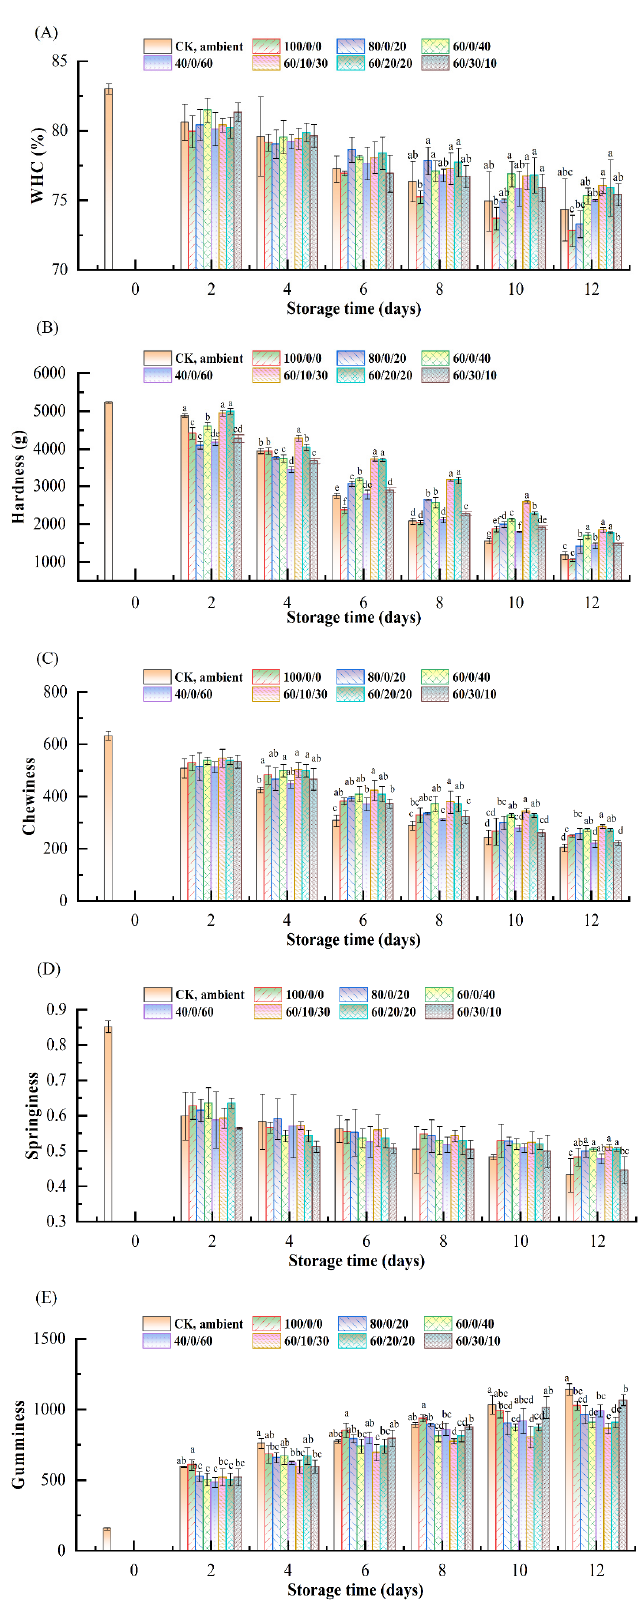
Figure 3. Changes of WHC ( A ), hardness ( B ), chewiness ( C ), springiness ( D ), and gumminess ( E ) of salmon fillets under MAP containing different CO 2 /O 2 /N 2 ratios at 4 °C. Different lowercase letters (a–d) represent significant differences ( p < 0.05) between different groups at the same storage period.